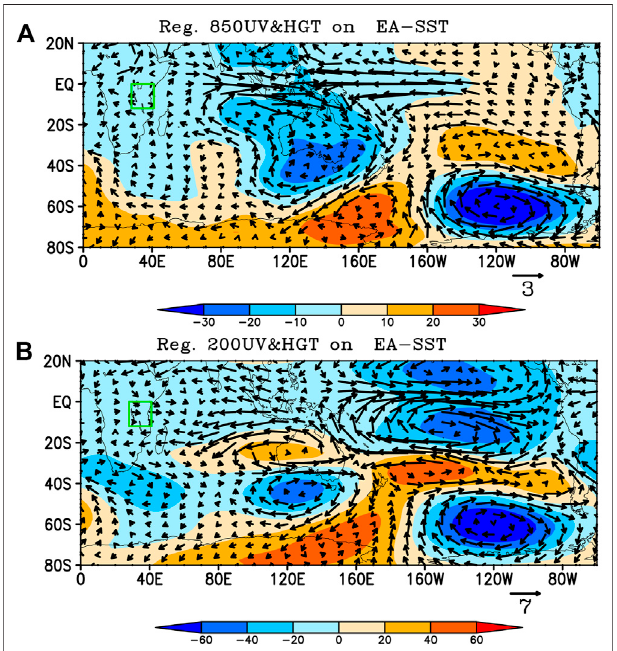
FIGURE 7 | Regressions of (A) 850 hPa horizontal winds (vectors; m s − 1 ) and geopotential height (shading; m), (B) 200 hPa horizontal winds (vectors; m s − 1 ), and geopotential height (shading; m) against the EA-SST during OND season for 1950 – 2017.